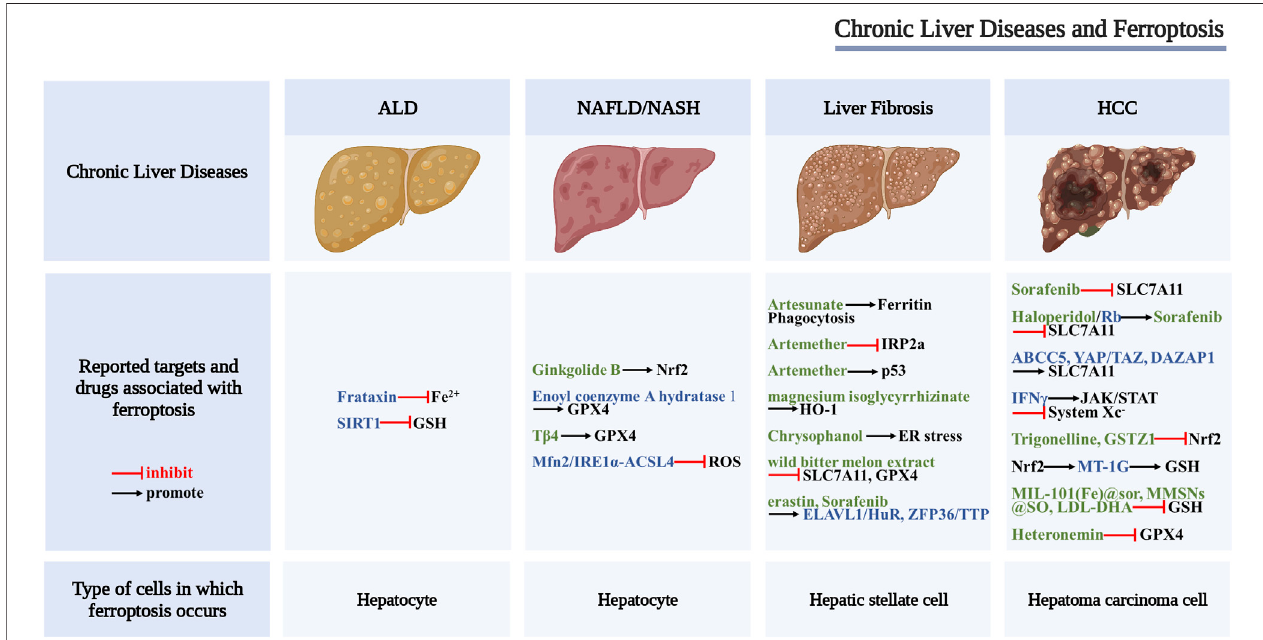
FIGURE 2 | Scheme of the proposed role of ferroptosis in chronic liver diseases. Drugs and key regulators associated with ferroptosis (black font), potential regulators of ferroptosis (blue font), and potential therapeutic drugs for ferroptosis (green font).